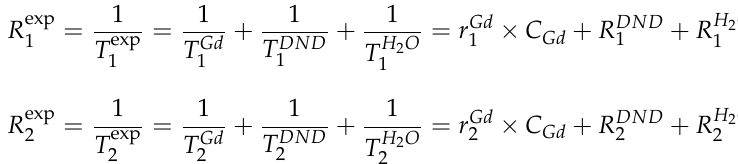
is the Gd(III) ions concentration in suspension.